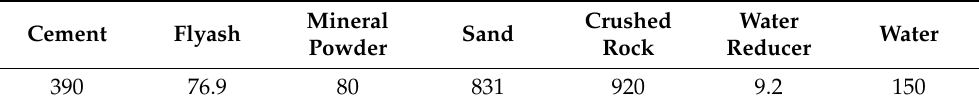
Table 2. Design of concrete (kg/m 3